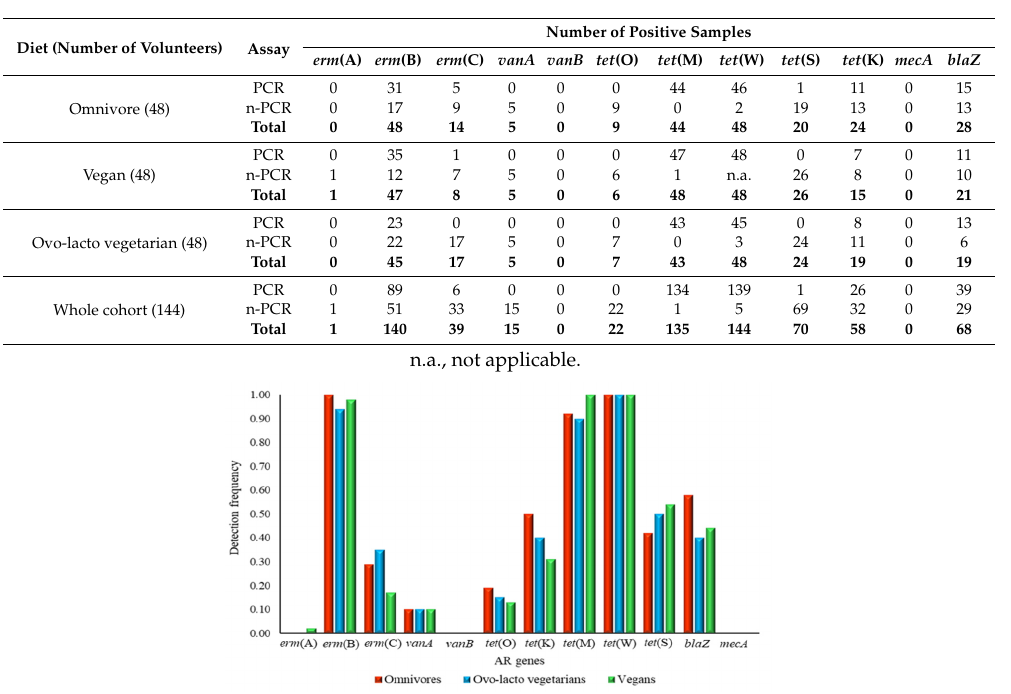
Table 2. Positive results of PCR and nested PCR (n-PCR) assays targeting the 12 antibiotic resistance (AR) genes of interest, carried out onto saliva samples collected from the three groups of heathy volunteers (each including 48 individuals) following long-term ( > 1 year) omnivore, ovo-lacto-vegetarian or vegan diet.